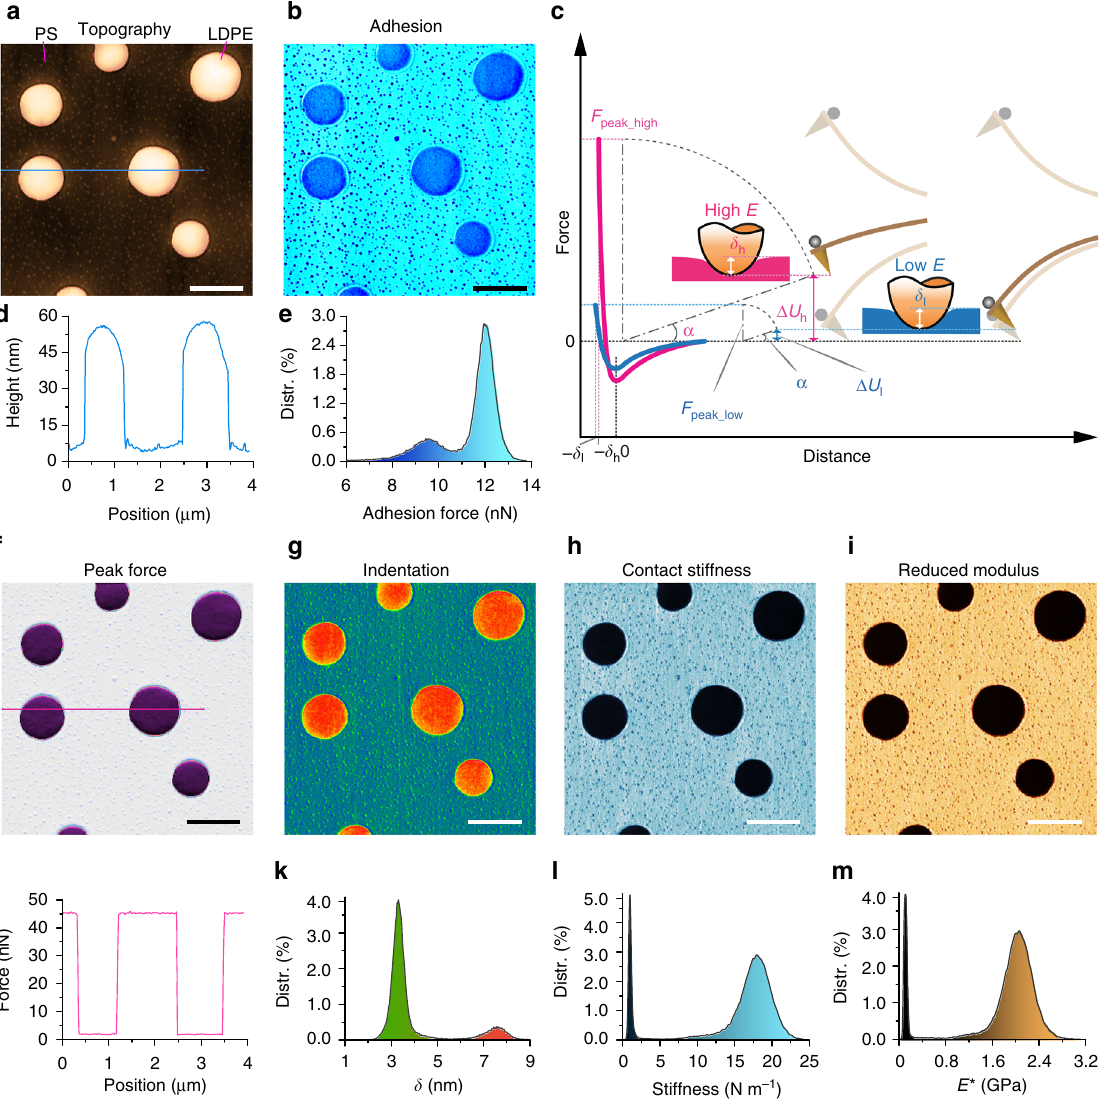
Fig. 5 Nanomechanical maps of a polymer blend using Probe I. Top-right inset c : Scheme of the variable peak force control for indentation depth regulation on a heterogeneous surface. a Topography. b Map of the adhesion force. d Cross-section along the line shown in a , showing that the LDPE islands were up to 45 – 50 nm higher than the PS matrix. e Histogram of the adhesion force map described in b . f Map of the peak force, which was instantaneously regulated according to the contact stiffness on the PS and LDPE regions. g Map of the indentation depth δ . h Map of the stiffness. i Map of the elastic modulus. j Cross-section along the line shown in f . k Histogram of the δ map described in g . l Histogram of the stiffness map described in h . m Histogram of the elastic modulus map described in i . Scale bar, 1 μ